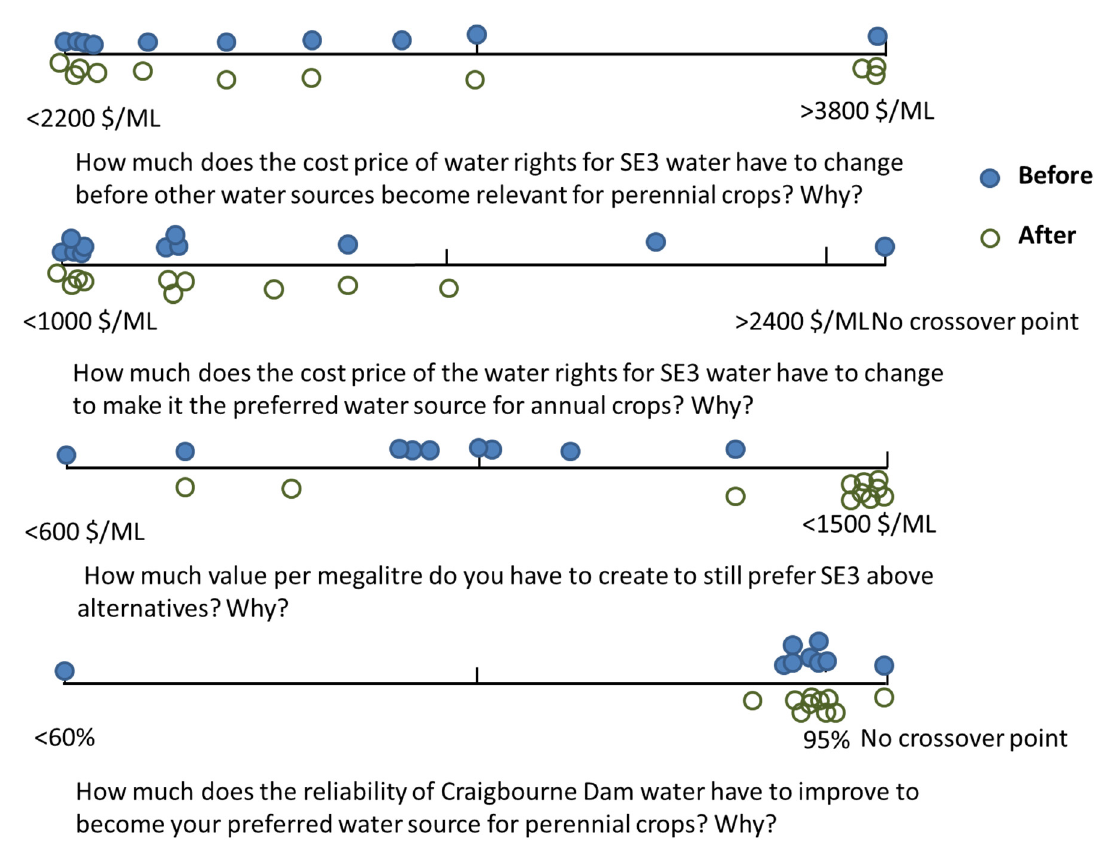
Figure A1. Crossover points of the participants with the crossover point before the discussion above the line and the crossover points after the discussion displayed below the line. The primary intent of asking for crossover points is to start as discussion; crossover points can not be understood as stand-alone results or willingness to pay. These crossover points are clearly subject to change, case-study dependent, and by no means representative. The Figure just shows the different perspectives within the group. Changes occurring during the discussion might be due to learning but also simply better understanding the question at hand.